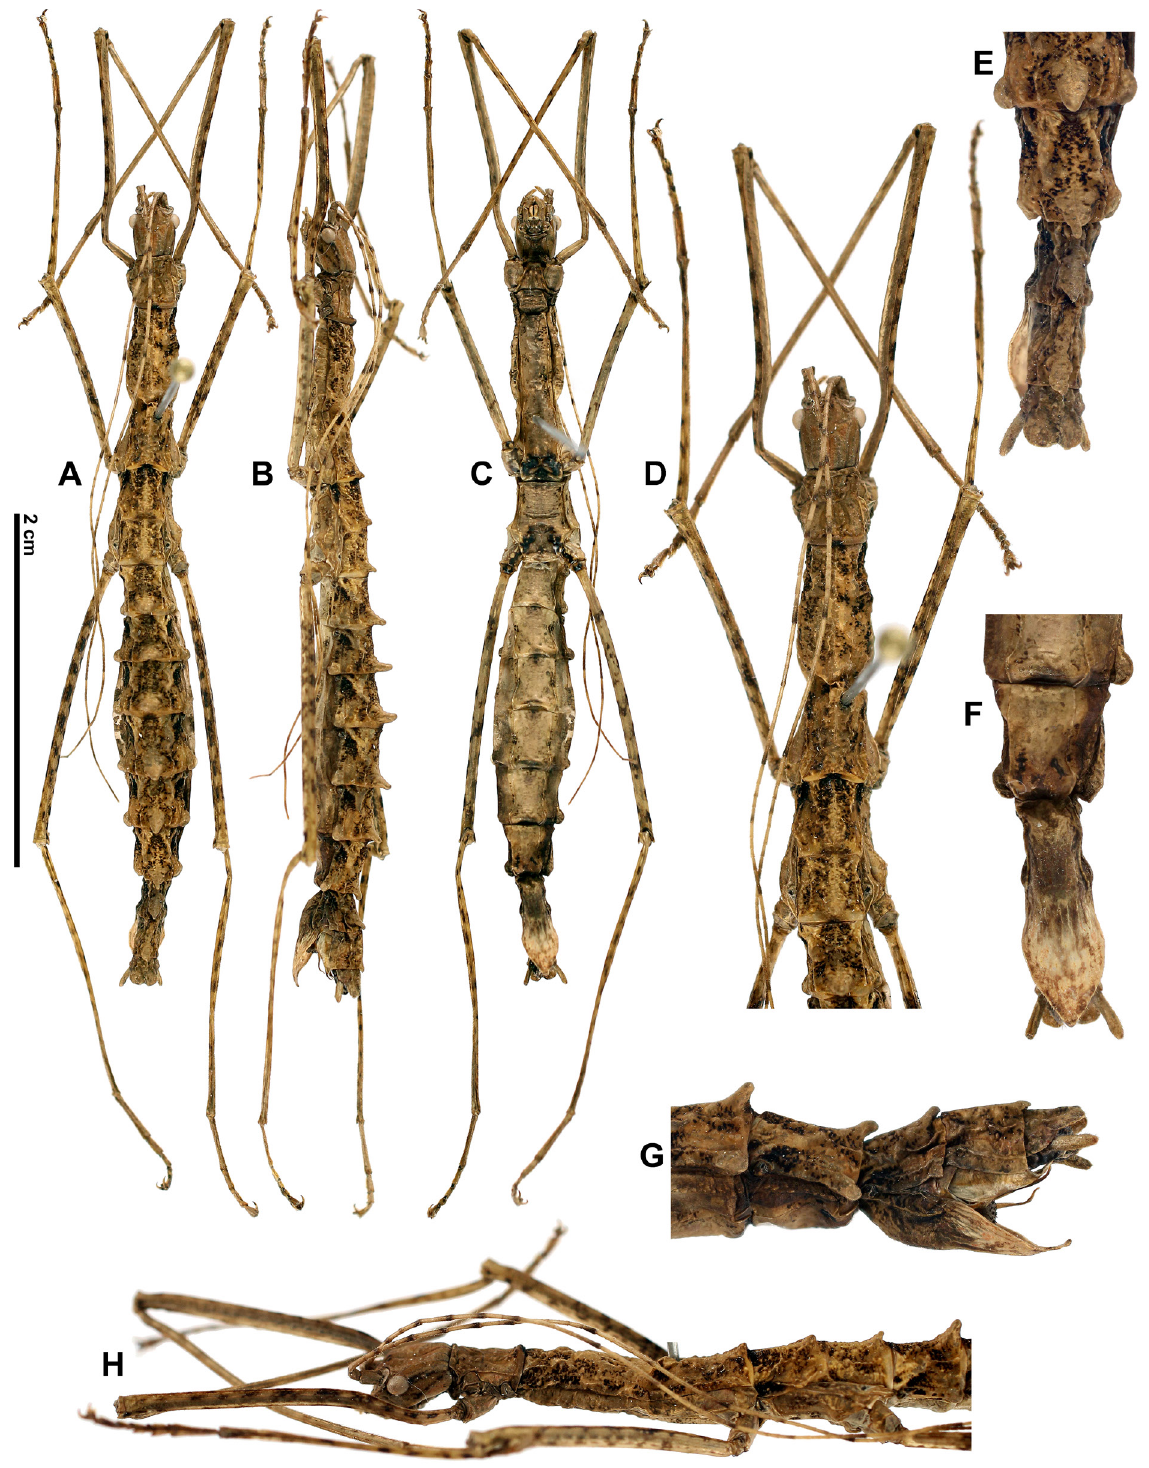
Fig. 12. Otraleus elizabethae sp. nov., ♀, paratype. A . Habitus, dorsal view. B . Habitus, lateral view. C . Habitus, ventral view. D . Anterior part of body, dorsal view. E . Apex of abdomen, dorsal view. F . Apex of abdomen, ventral view. G . Apex of abdomen, lateral view. H . Anterior part of body, lateral view. D–H: not to